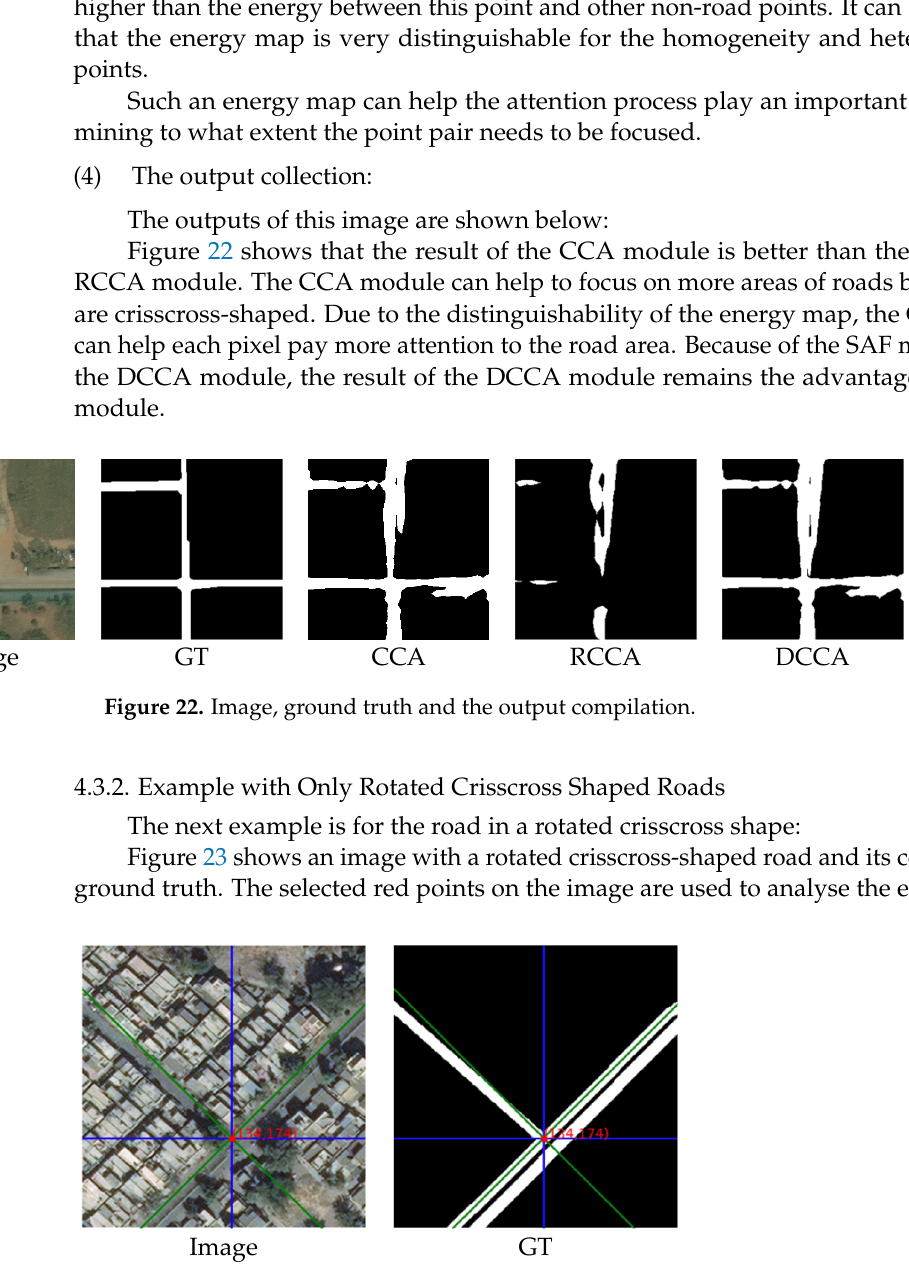
Table 6. The energy comparison of CCA and RCCA sampling.